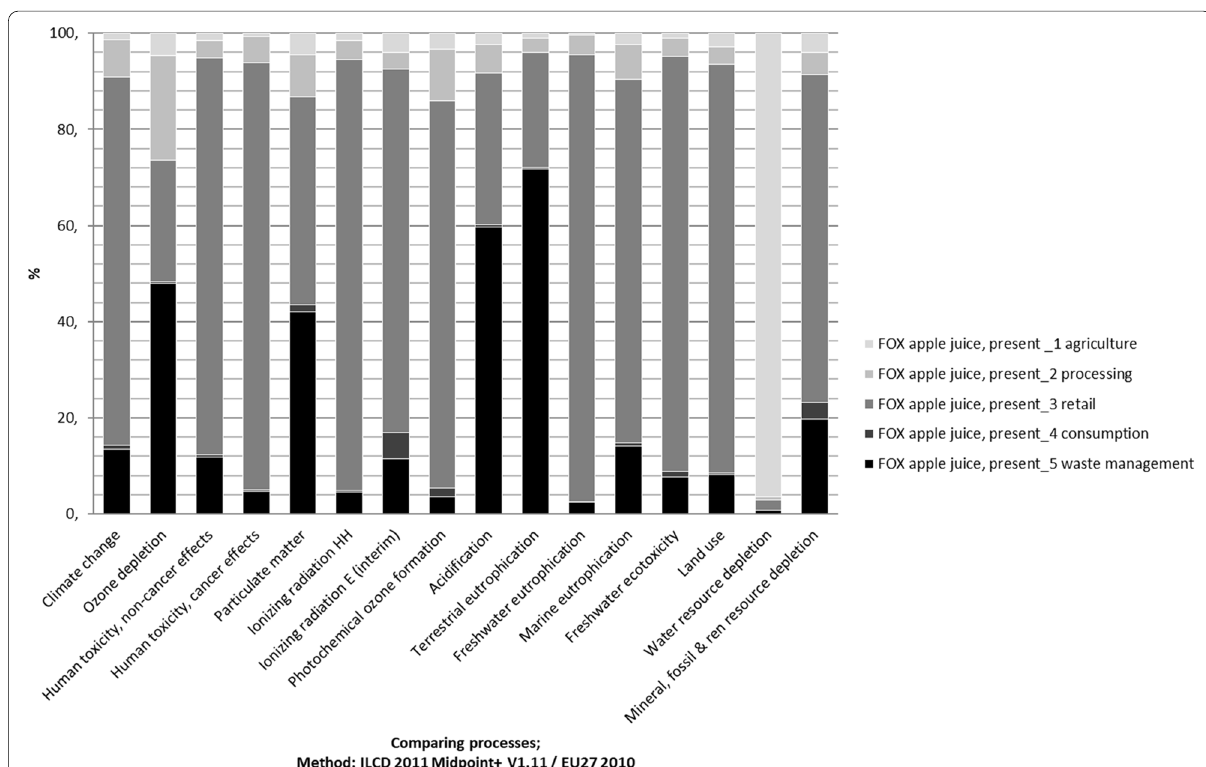
Fig. 6 Impact per supply chain stage of FOX apple juice in the present; characterized factors, method: ILCD 2011 Midpoint